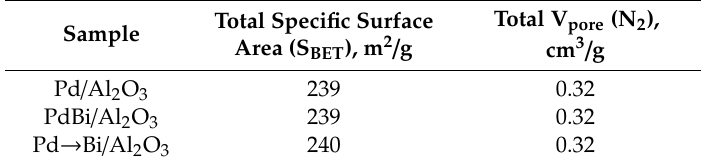
Table 9. Total surface area (S BET ) and total pore volume (V pore ) of obtained catalysts according to nitrogen